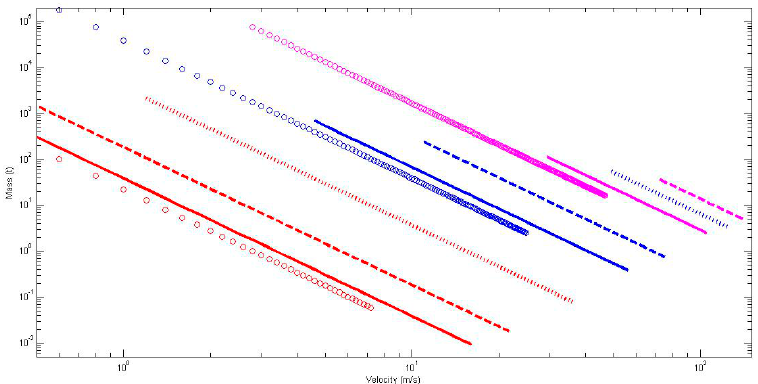
Figure 4. Maximum mass of the laminar neutrally buoyant hulls in water (“circles”) and in air at attitudes 0, 10 and 20 km (solid, dashed and dotted lines respectively). The color of lines and “circles” corresponds to the body thickness D / L = 0.02, 0.05 and 0.278 (magenta, blue and red respectively).